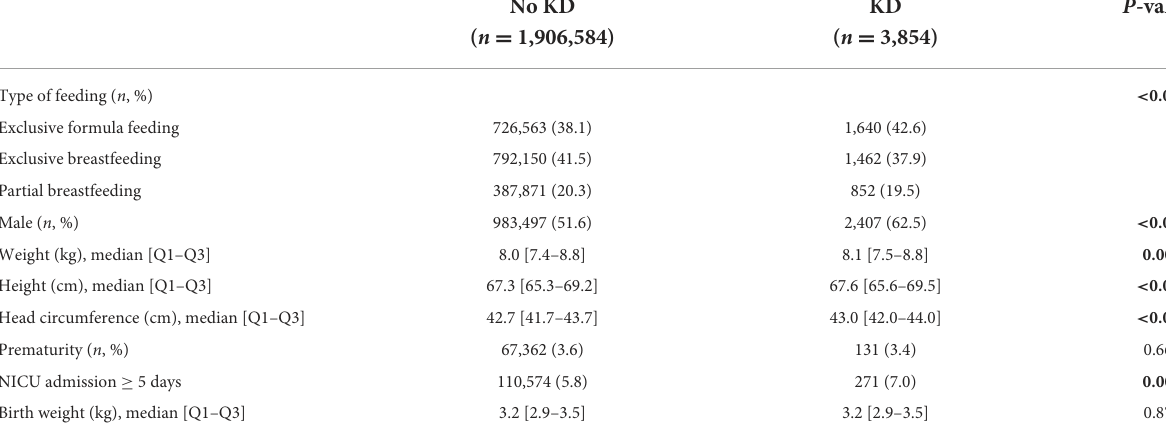
TABLE 2 Univariable analysis of attributing factors for Kawasaki disease at 10–12 months of follow-up